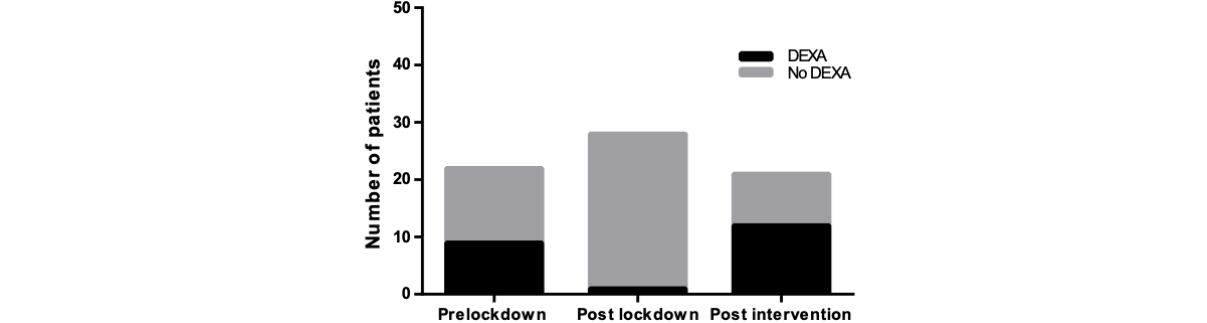
Figure 5. The number of patients being offered a DEXA (dual energy X-ray absorptiometry) scan after the lockdown was significantly reduced ( P <.001); post intervention, there was a significant increase in patients being requested a DEXA scan ( P <.001). While numbers of DEXA scans offered increased post intervention compared to the prelockdown period, this was not statistically significant ( P